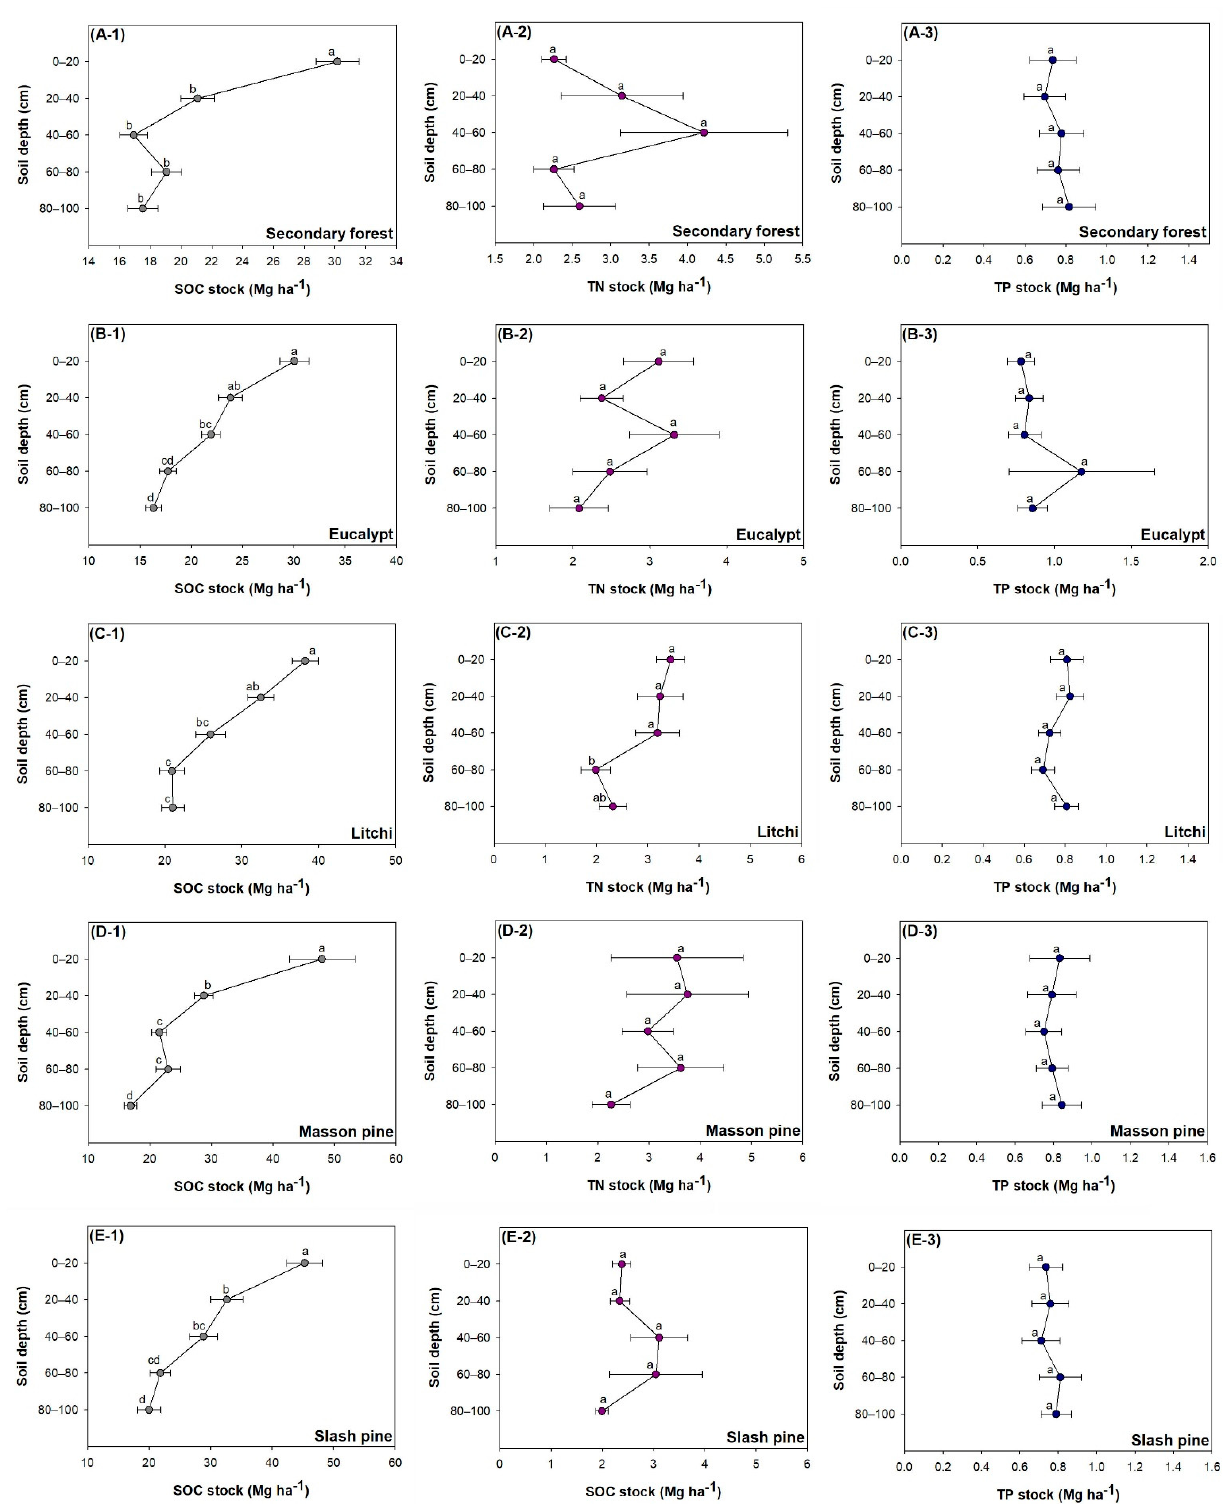
Figure 5. Differences of storages in soil organic carbon (SOC) ( A-1 , B-1 , C-1 , D-1 , E-1 ), total nitrogen (TN) ( A-2 , B-2 , C-2 , D-2 , E-2 ), and total phosphorus (TP) ( A-3 , B-3 , C-3 , D-3 , E-3 ) in five soil layers at depths of 0–20 cm, 20–40 cm, 40–60 cm, 60–80 cm, and 80–100 cm from stands of secondary forests and four types of plantations of Eucalypt ( Eucalyptus obliqua L’Hér.), Litchi ( Litchi chinensis Sonn., 1782), Masson pine ( Pinus massoniana Lamb.), and Slash pine ( Pinus elliottii Engelm.) in Yunfu, Guangdong province, South China. Bars indicate standard deviations. Different letters beyond bars indicate significant difference detected by paired t -test at 0.05